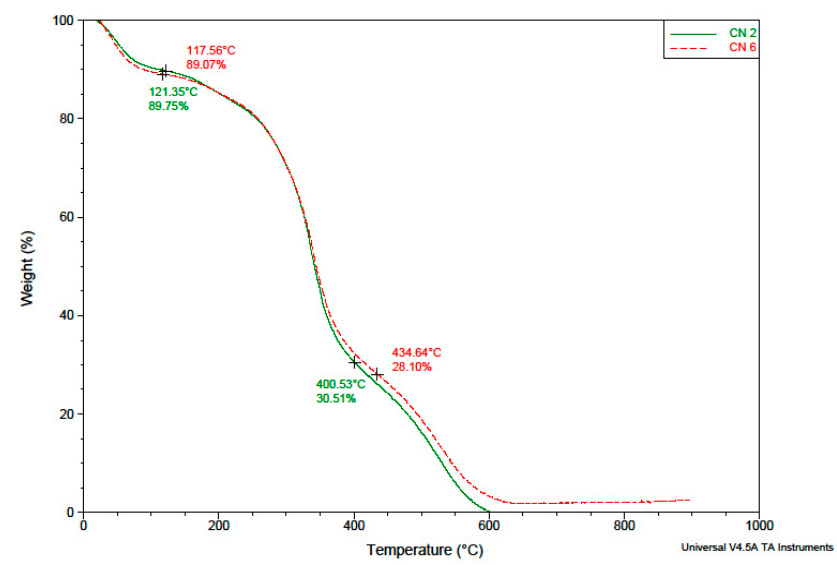
Figure 5. TGA chromatograms of NCs samples.